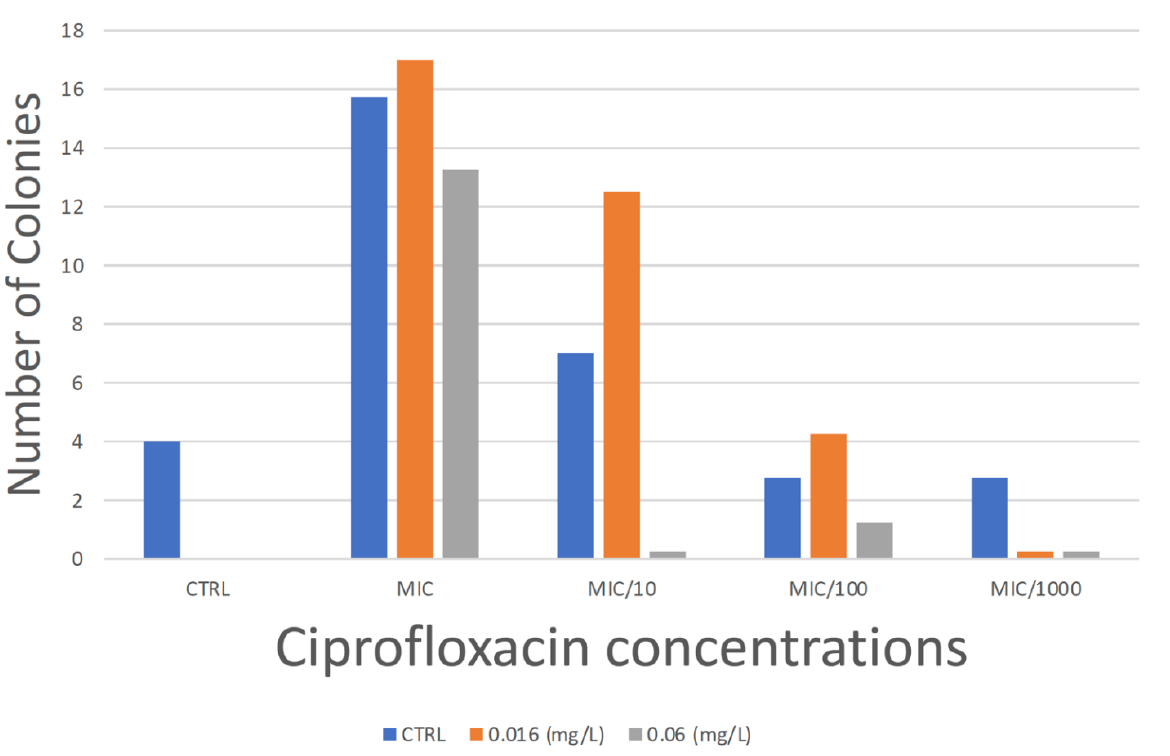
Figure 1. Growth distribution of colonies. Mean number of colonies of N. gonorrhoeae grown at 7 days in different ciprofloxacin concentrations ranging from 1xMIC to 1/1000th MIC of WHO-P, stratified according to their final growth in plates with no ciprofloxacin, 0.016 mg/L and 0.06 mg/L. All the experiments were conducted in quadruplicate.